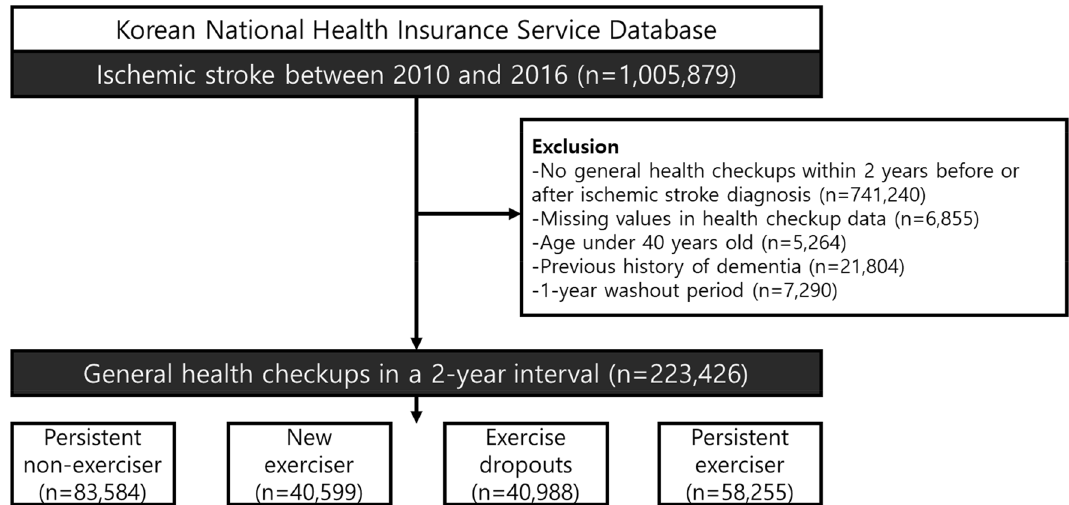
Figure 1. Flowchart of the selection of